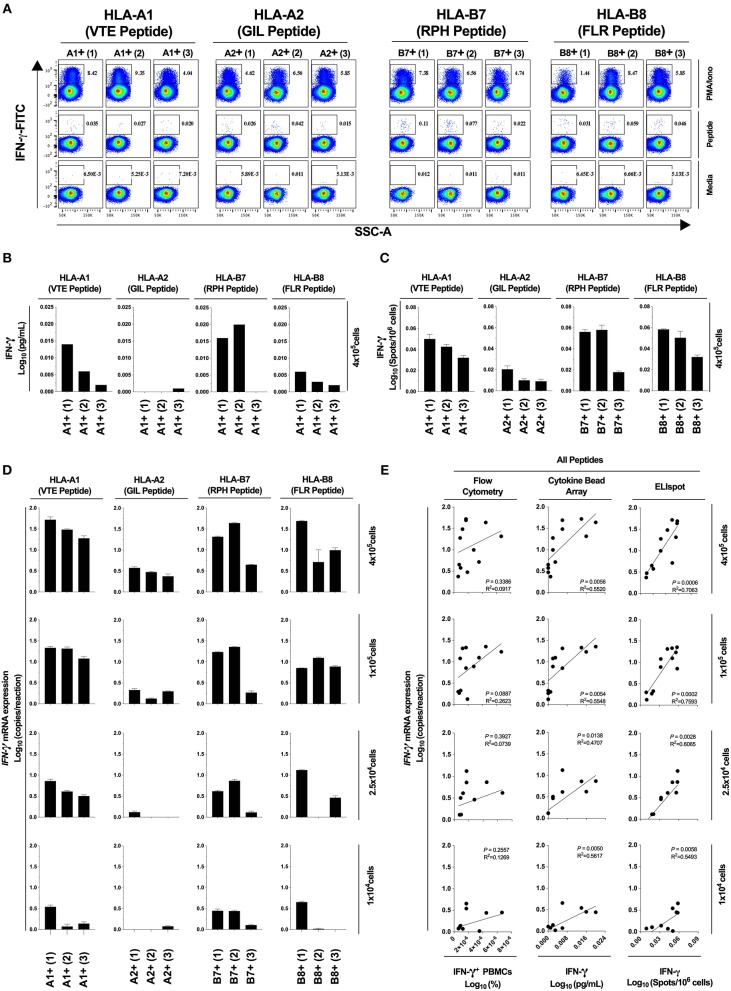
Assay diagnostic sensitivity. Production of IFN-γ protein was determined by flow cytometry (A), bead-based multiplex assay (MagPIX) (B), IFN-γ ELIspot (C); or IFN-γ mRNA expression by absolute RT-qPCR (D). IFN-γ mRNA expression was correlated to measurements of protein production by flow cytometry, MagPIX or IFN-γ ELIspot (E; left, middle and right panel, respectively). Biological replicate (n = 3) per HLA-A1, HLA-A2, HLA-B7, or HLA-B8 positive PBMCs (i.e., n = 12 total) were stimulated with synthetic HLA-matched peptides representing CMV, Influenza or EBV CD8+ T cell epitopes “VTE,” “GIL,” “RPH,” or “FLR” (black), respectively. All samples were cultured with media negative control or PMA/Iono positive control. IFN-γ mRNA expression was determined by absolute quantification RT-qPCR of titrated PBMCs (4 × 105, 1 × 105, 2.5 × 104, and 1 × 104); gene copy number per reaction was quantified by standard curve and log10 transformed. Single RNA extractions, with single reverse transcription reactions per n, were performed. qPCR performed in technical triplicate replicates. Flow cytometry and MagPIX performed in single wells. ELIspot performed in technical triplicate replicates. Sample mean calculated from the mean of the technical single or triplicates. Biological mean ± technical SEM above background shown.